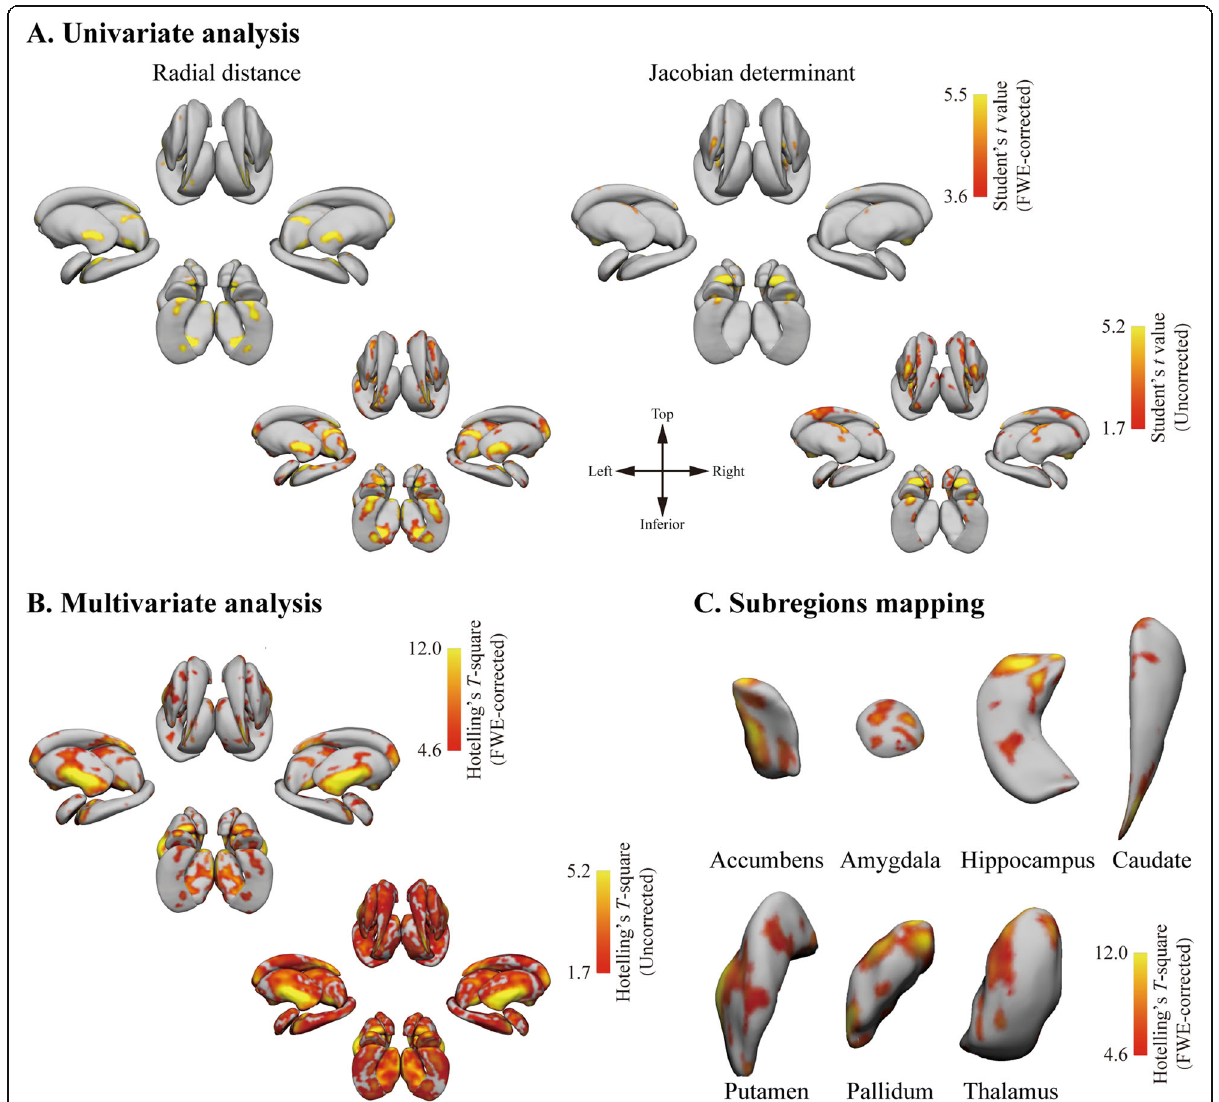
Fig. 2 Subcortical surfaced-based feature analysis. A Univariate group analyses indicating clusters that were significantly altered relative to controls. B Multivariate analysis assessing the joint distribution of the radial distance and Jacobian deformation. Bar plots correspond to comparisons between patients and controls with respect to different subcortical features for different significant clusters. The t values are indicated by colored bars, with random field theory having been used to correct significant clusters for multiple comparisons at P FWE < 0.05. C Subregional mapping results (left side only, as all samples were flipped such that the affected side was to the